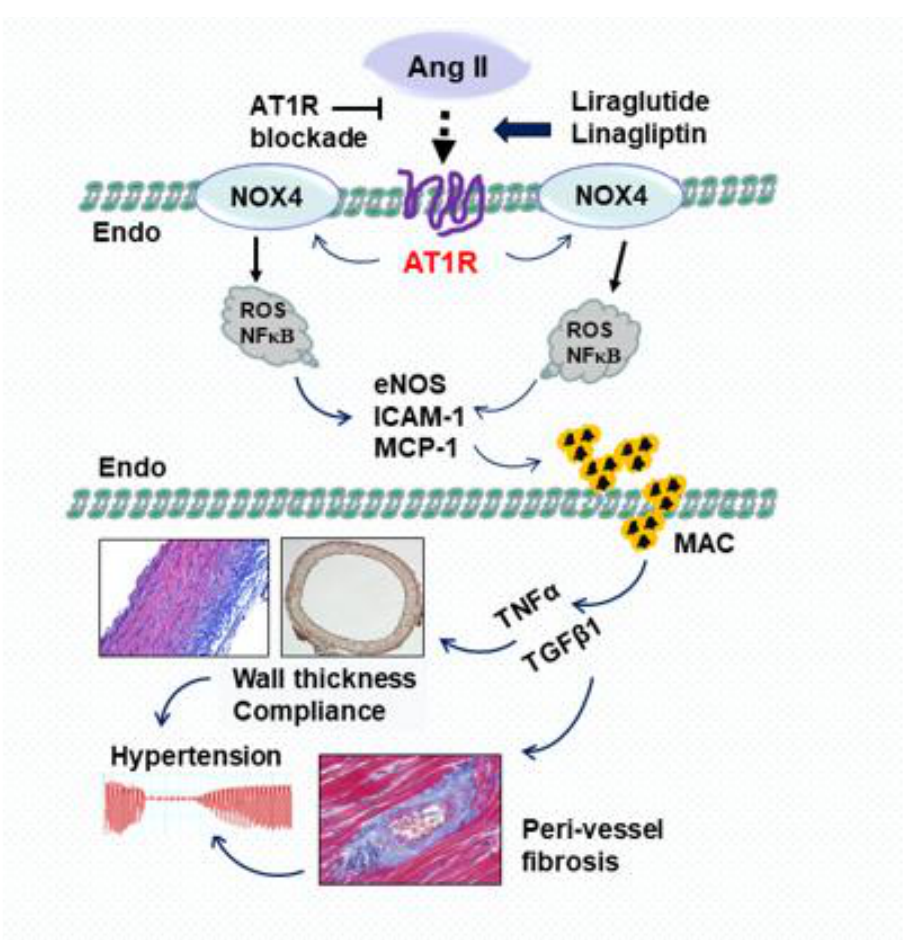
Figure 3. The signaling pathways proposed in vascular protection by preserving GLP-1 using the GLP-1R agonist liraglutide and DPP-4 inhibitor linagliptin as well as the AT1R blockade. Ang II activates NOX4/NADPH oxidase expressed on the endothelium by stimulating AT1 receptor. The increased production of reactive oxygen species (ROS) and NF κ B by NOX4 causes eNOS uncoupling, enhances the expression of intercellular adhesion molecule-1 (ICAM-1) and monocyte chemoattractant protein-1 (MCP-1), and facilitates the migration/infiltration of monocytes/macrophages (MAC). TNF α and TGF β 1 released from macrophages increase vascular wall thickness, decrease vascular compliance and induce perivascular fibrosis, resulting in endothelial dysfunction and hypertension. Upregulating GLP-1 levels with liraglutide/linagliptin or blocking AT1R inhibits the cascades of the Ang II/NOX4/ROS signaling pathways, and protects vascular function via inhibiting Ang II-induced vascular remodeling. Endo: